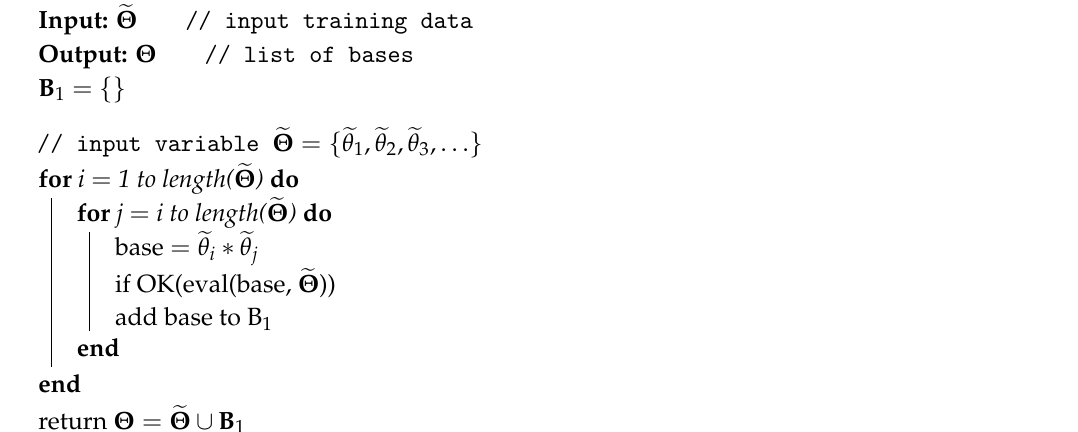
Algorithm 1: Generate interacting variable bases limiting to quadratic